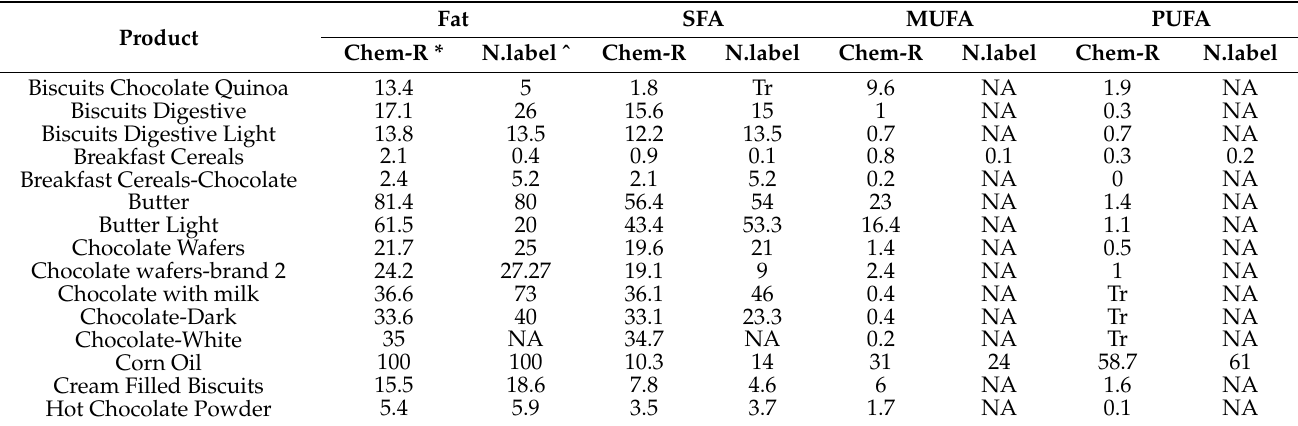
Table 5. Comparison between actual nutrient analysis values of market food products and reported nutrient values on nutrition fact